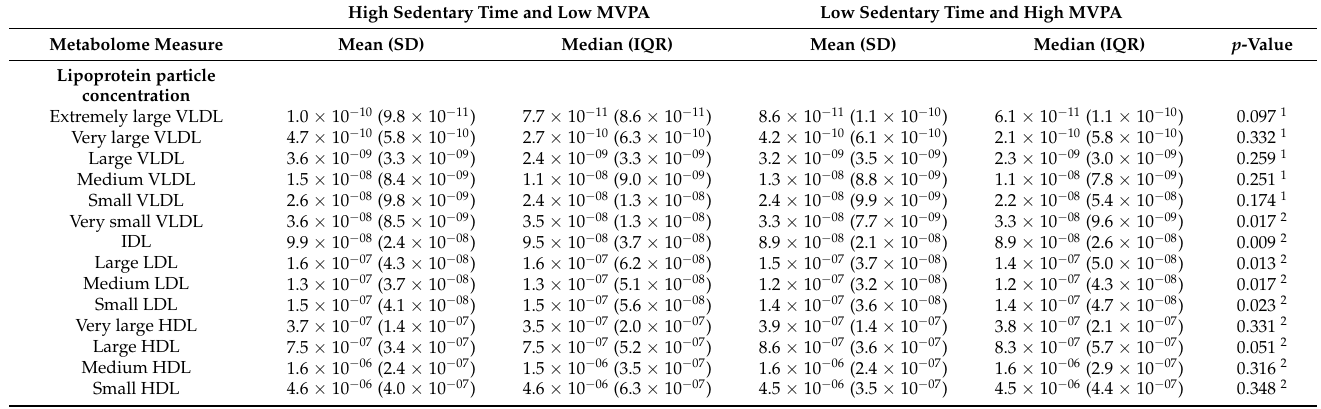
Table 4. Comparison (mean with standard deviation (SD) and median with interquartile range (IQR)) between a group with high sedentary time and low moderate-to-vigorous physical activity (MVPA) ( n = 77), and a group with low sedentary time and high MVPA ( n = 86). High Sedentary Time and Low